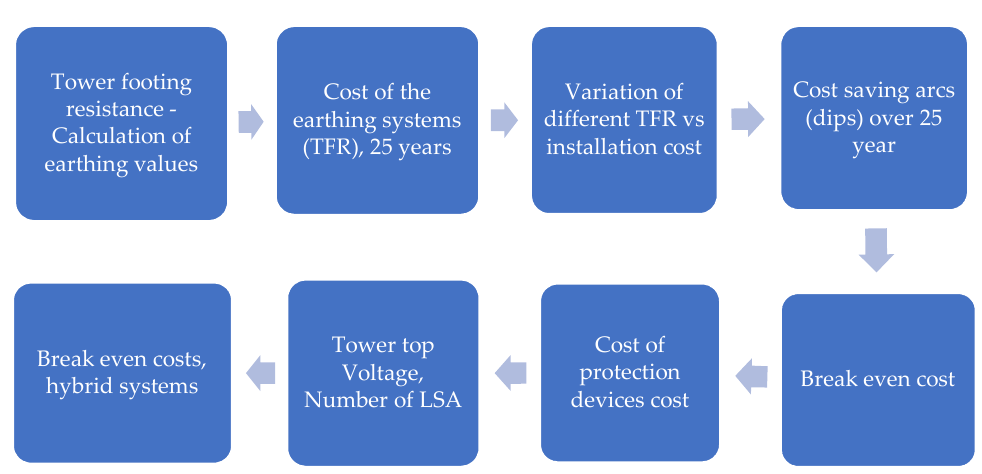
Figure 2. Process diagram to determine breakeven cost w.r.t earthing enhancement, the needed number of surge arresters, and cost-saving in preventing interruptions in power.